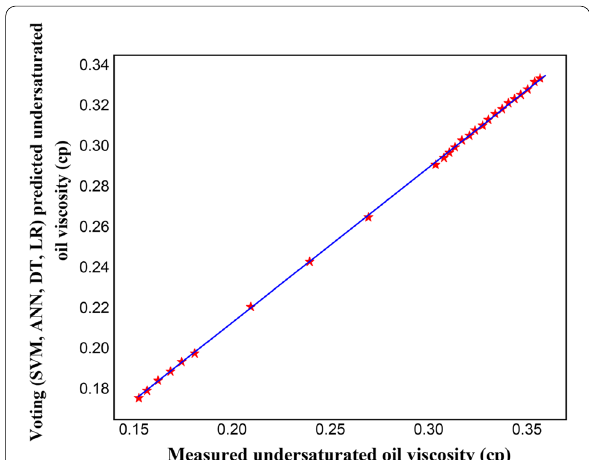
Fig. 27 Cross plot of voting (ANN, SVM, DT, LR) predicted values versus measured values